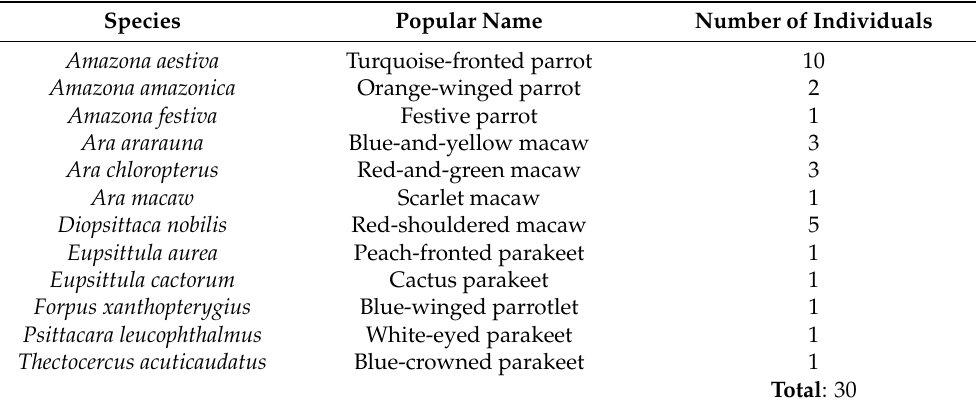
Table 1. Psittaciformes species sampled for cloacal swabs at the Centro de Triagem de Ani- mais Silvestres da Para í ba (CETAS-PB), located in the Restinga de Cabedelo National Forest, Para í ba State, Brazil. Species Popular Name Number of Individuals Amazona aestiva Turquoise-fronted parrot 10 Amazona amazonica Orange-winged parrot 2 Amazona festiva Festive parrot 1 Ara ararauna Blue-and-yellow macaw 3 Ara chloropterus Red-and-green macaw 3 Ara macaw Scarlet macaw 1 Diopsittaca nobilis Red-shouldered macaw 5 Eupsittula aurea Peach-fronted parakeet 1 Eupsittula cactorum Cactus parakeet 1 Forpus xanthopterygius Blue-winged parrotlet 1 Psittacara leucophthalmus White-eyed parakeet 1 Thectocercus acuticaudatus Blue-crowned parakeet 1 Total :